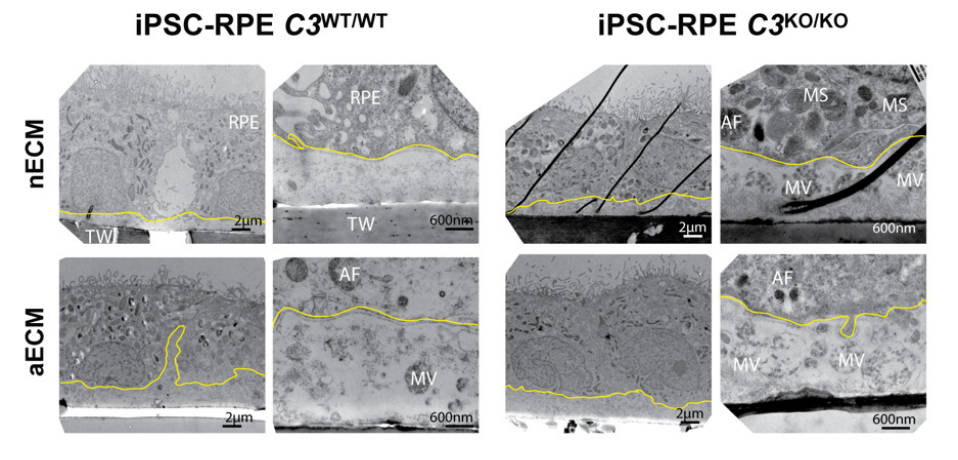
Figure 5. RPE monolayers on aECM show irregular topography and release microvesicles. Trans- mission electron micrographs of iPSC-RPE cells on transwells coated with nECM and aECM after 20 weeks. Left panels of each genotype are representative low magnification images, and right panels are representative high magnification images. The basal membranes of the RPE are delineated with yellow lines. TW: transwell, MV: microvesicles, MS: melanosomes, and AF: autophagosomes.